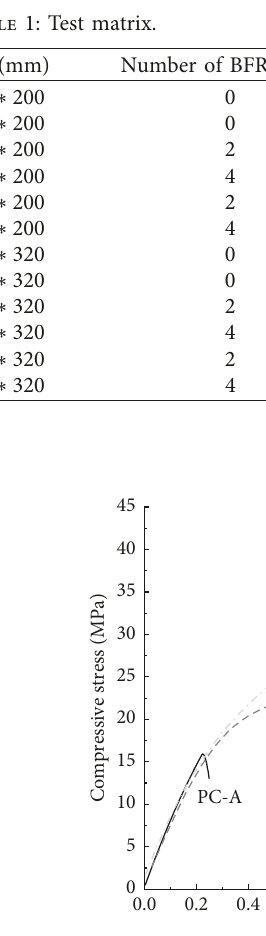
Figure 4: Effect of BFRP layers on the axial stress-strain behavior of the 100 ∗ 200mm BFRP-PC.